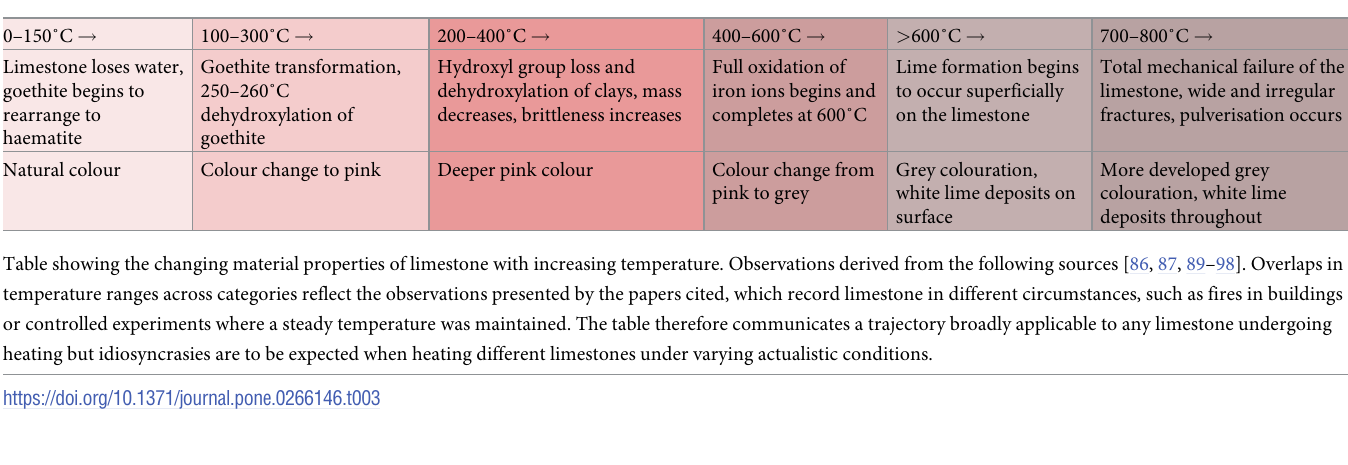
Specific comparison between the archaeological and experimental plaquettes was facilitated through colour enhancement of high resolution photographs via DStretch © . DStretch © is a plugin for the ImageJ © digital imaging software first developed for use in rock art research by John Harman in 2005, and enables the user to manipulate specific colours in an image [121].